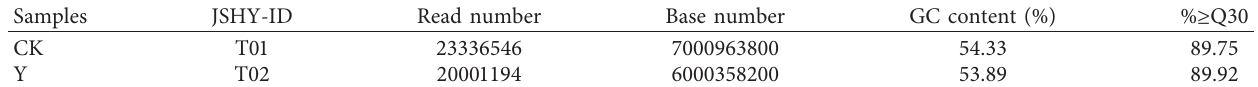
Table 2: Transcriptome sequencing data of P. expansum treated with M. guilliermondii (Y) and P. expansum (CK). Samples